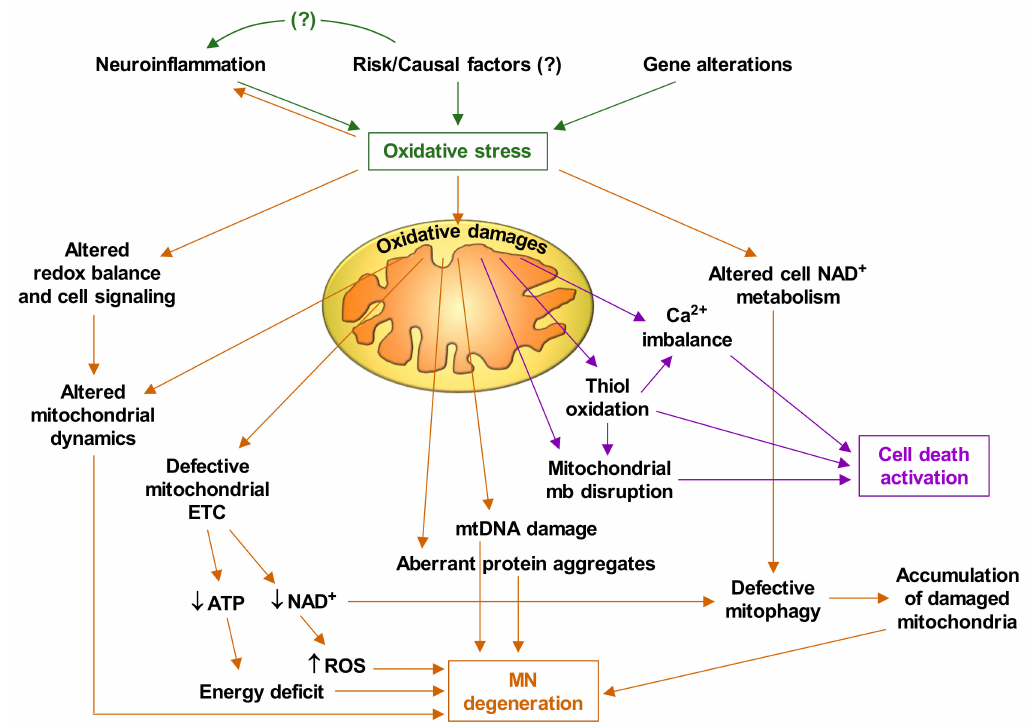
Figure 1. Oxidative stress-induced motor neuron degeneration and death. ALS is caused by interplay of various molecular pathways in motor neurons and an interaction with neighboring glial cells and different undefined risk/causal factors. ETC, electron transport chain; mtDNA, mitochondrial DNA; mb, membrane. It is suspected that this cascade of events gradually damages motor neurons until (a still undefined) a-point-of-no-return threshold is reached and cell deterioration and death are irreversible